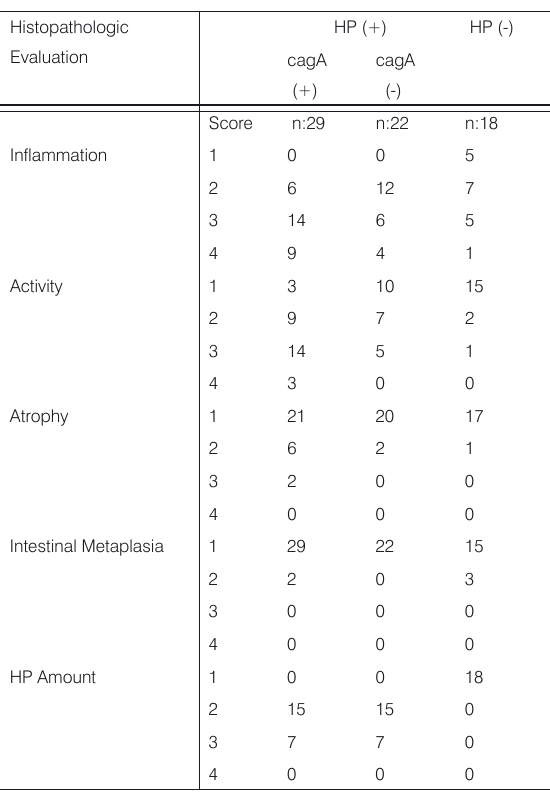
Table 3. Histopathologic scores (according to the Sydney criteria, reference 8) and cag A PCR detection results of HP positive and negative